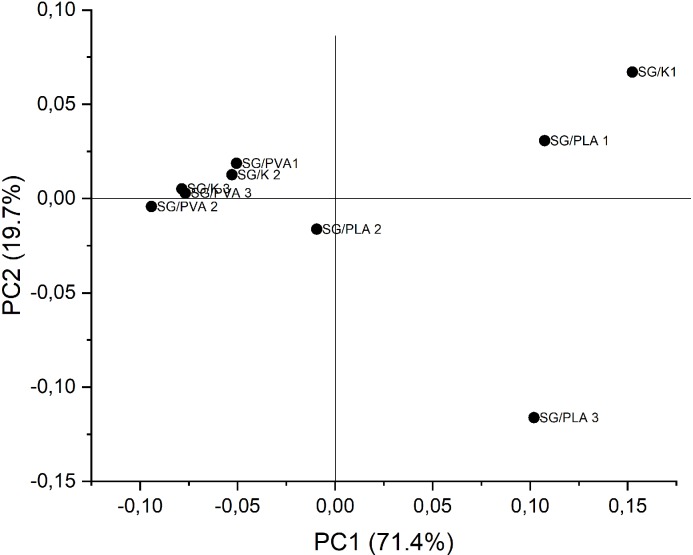
PCA score plot as 2D (PC1xPC2) derived from the FTIR spectra.